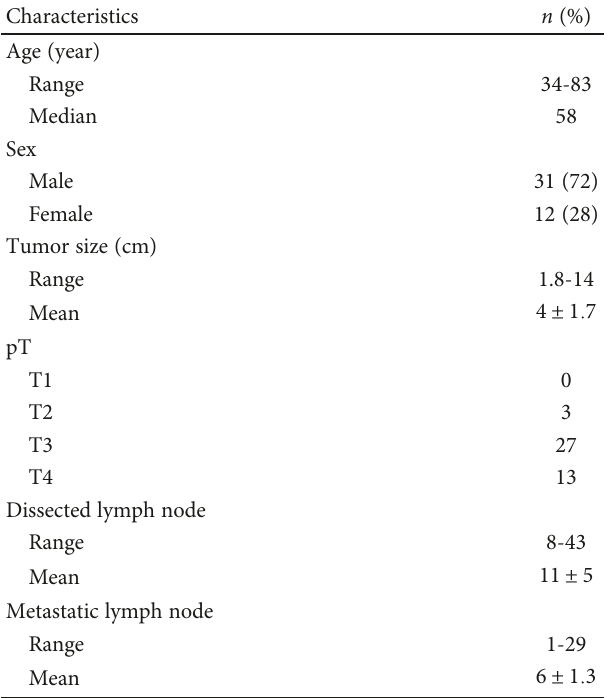
Table 1: Patients characteristics ( n = 43